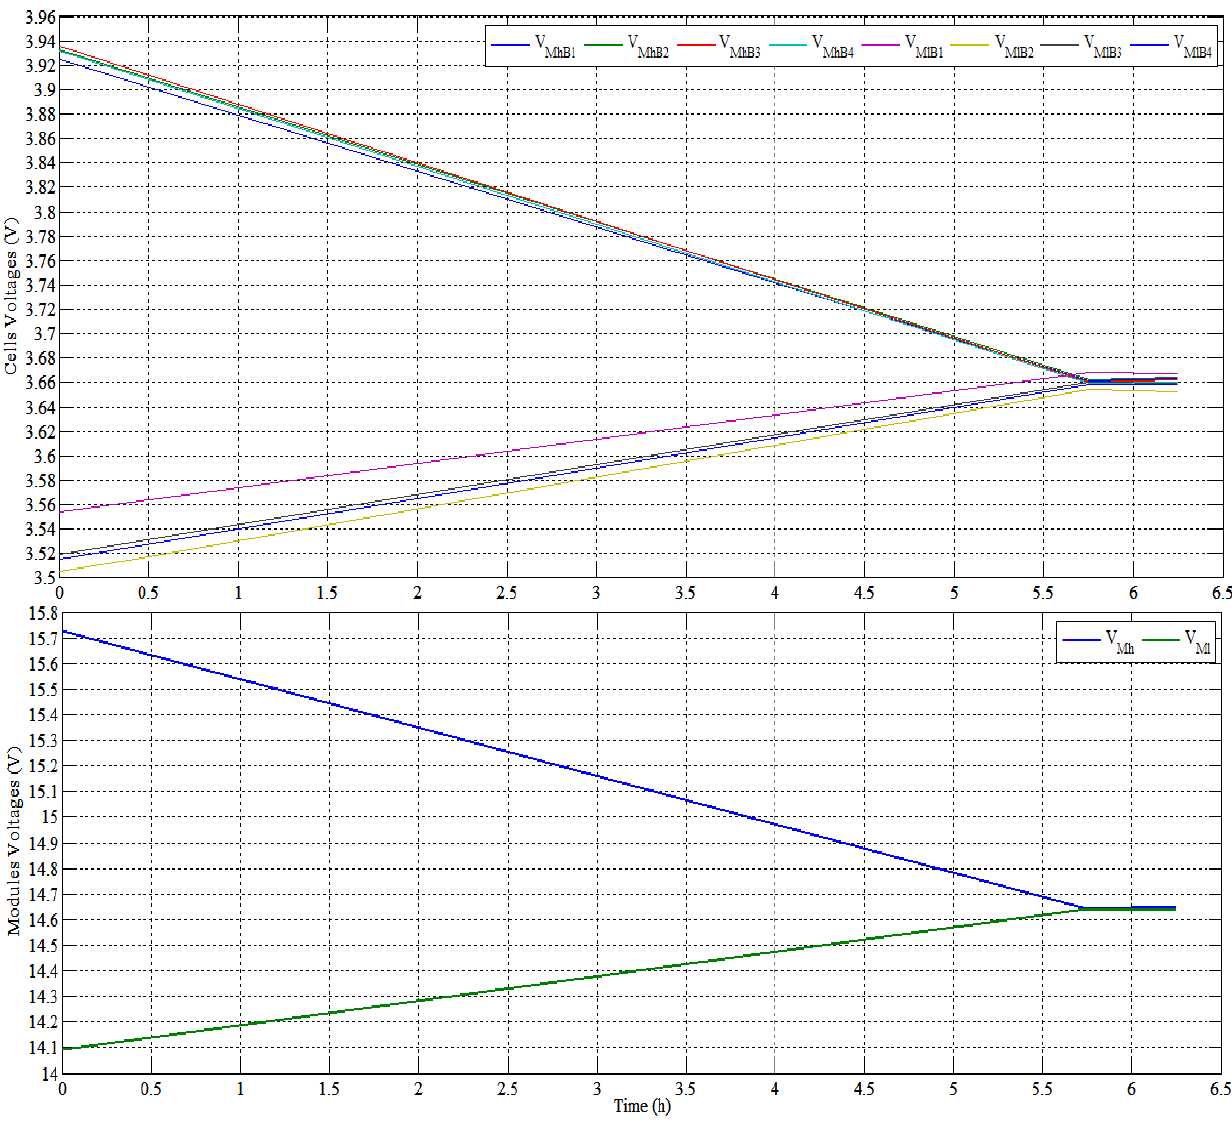
Figure 36. Experimental results of 20 A·h cells with between modules converter balancing Test No. 3 (top to bottom), the two modules’ cells voltages, modules voltages, modules voltages screen